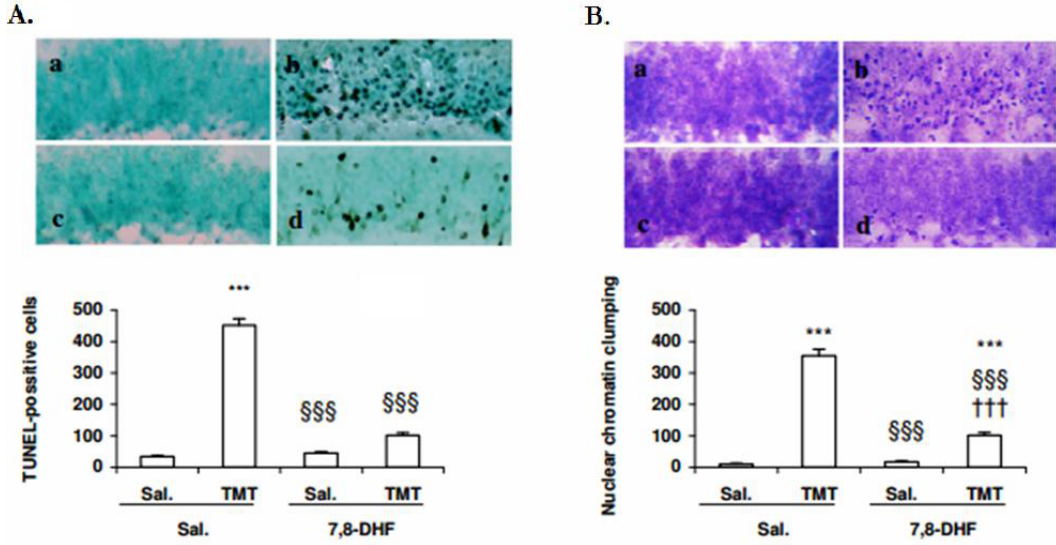
Figure 3. In the presence of 7,8-DHF, TMT-induced TUNEL-positive cells (Figure A - a, saline; b, TMT; c, 7,8-DHF 10 mg/kg; d, 7,8-DHF 10 mg/kg +TMT) and nuclear chromatin clumping counts assessed by cresyl violet staining (Figure B - a, saline; b, TMT; c, 7,8-DHF 10 mg/kg; d, 7,8- DHF 10 mg/kg +TMT) were observed. Each scale bar = 100μm. Each value is expressed as the mean±S.E.M of six mice. * P <0.05, *** P <0.001 as compared to the saline-treated group; §§§ P <0.001 as compared to the 2d after TMT-treated group; ††† P <0.001 as compared to 7,8-DHF-treated group (The data was analyzed one-way ANOVA followed by Fisher's PLSD